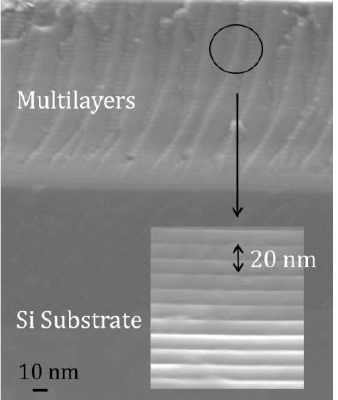
Figure 4. SEM image of cross-section of a 10-nm layer multilayer film on silicon.